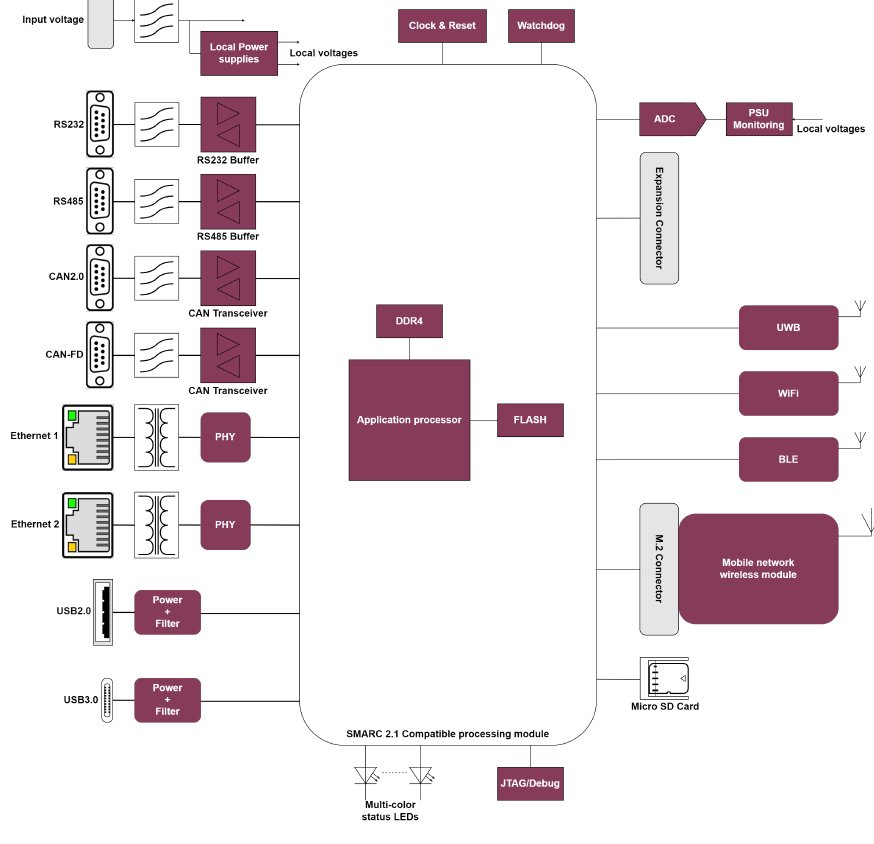
Figure 14. GWEN components overview.